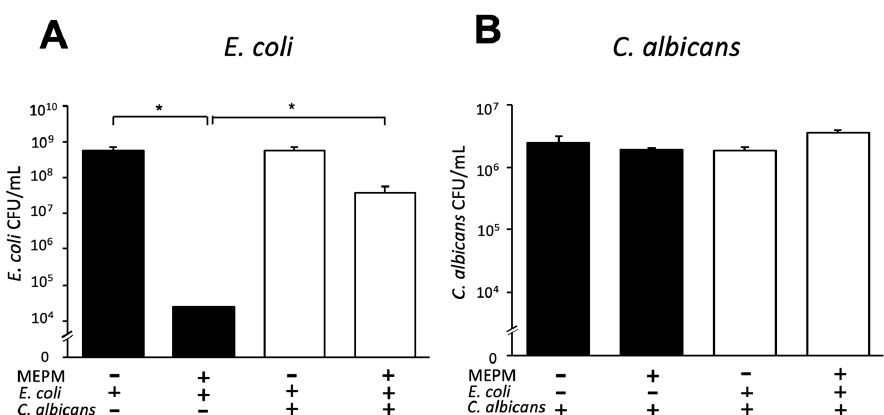
Figure 3. Antimicrobial effects of MEPM against a dual-species biofilm with E. coli and C. albicans . ( A ) Survival of E. coli RB-3 in single (black) and dual-species (white) biofilms treated with or without MEPM (50 μ g/mL); only E. coli was quantified using a selective medium containing micafungin. ( B ) Survival of C. albicans in single (black) and dual-species (white) biofilms treated with or without MEPM (50 μ g/mL); only C. albicans was quantified using a selective medium containing streptomycin. Measurements were performed three times, and the data are the means ± standard deviations. n = 3/group. Statistically significant differences between groups were evaluated using Tukey’s test with one-way ANOVA; * p < 0.05.